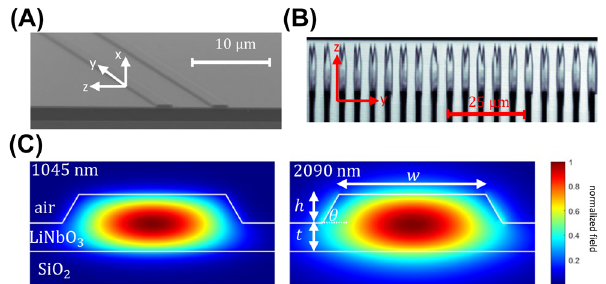
Figure 2: Images of the PPLN nanophotonic waveguide.